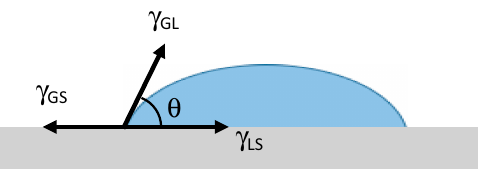
Figure 4. Illustration of the static contact angle θ , formed by sessile liquid drops on a solid surface, and of the relative surface energies of solid–liquid (SL), gas–liquid (GL), and gas–solid (GS). This relationship is mathematically described by the Young equation: γ GS = γ LS + γ GL cos θ . In the case of complete wetting (spreading), the contact angle is 0°. This means that the solid sample has a much high surface energy than the liquid; between 0° and 90°, the solid substrate is wettable, and above 90° it is not wettable. This means that the solid has a surface energy much lower than the liquid. In terms of surface texture, which strongly influences the wetting behavior of a surface [28], AFM analyses demonstrated that the SiOx coating layer is quite homogeneous and smooth, and has much lower surface roughness, in the range of atomic sizes, than the PET side of the film. With the aim of analyzing the effect of the silane concentration per film surface area on the changes in film wettability, due to SAM reaction, all the modified samples were submitted to static contact angle measurements, using water and oil as a test liquid. Figures 5 and 6 compare the CAw and CAo values, respectively, evaluated on both sides (i.e., the uncoated and the SiOx-coated side) of the films.